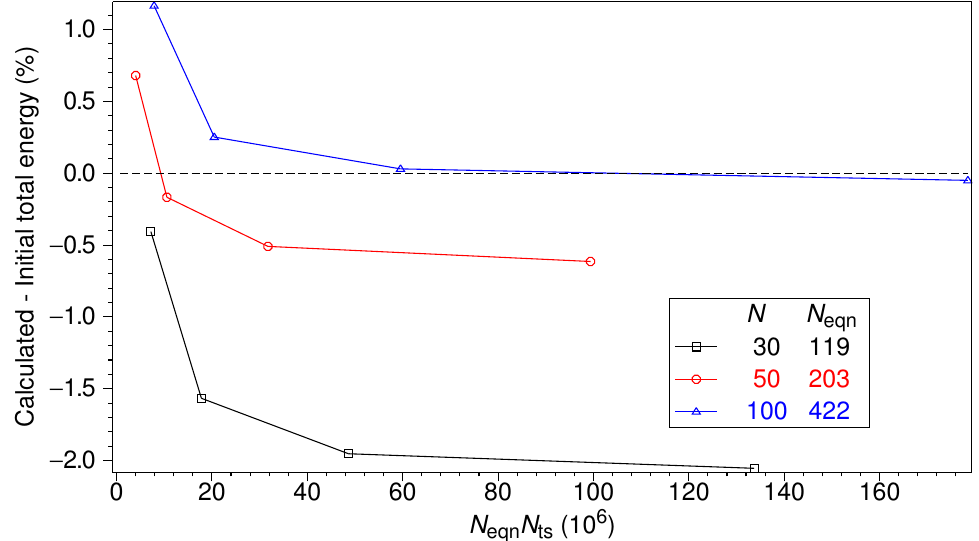
Figure 9. Percentage errors in the total energy for N = 30, 50 and 100, for in each case (left to right) f = 10 − 4 , 10 − 5 , 10 − 6 and 10 − 7 , plotted as a function of the computational load ( N eqn N ts